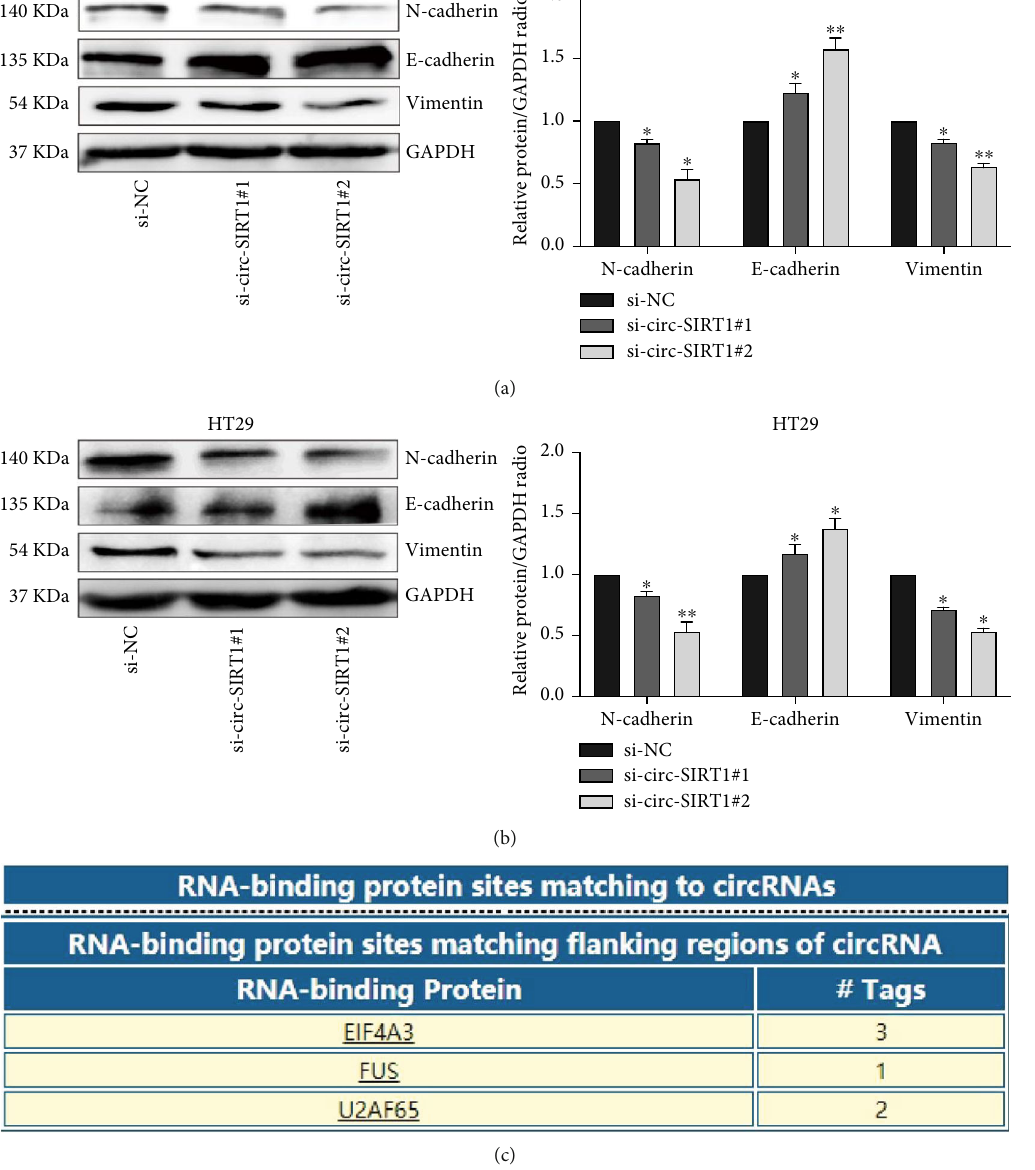
Figure 4: The relationship between low expression of circ-SIRT1 and EMT. Knockdown of circ-SIRT1 can inhibit the EMT process by inhibiting the expression of mesenchymal marker protein (a) and (b). Predict the proteins that can bind to circ-SIRT1 through circInteractome